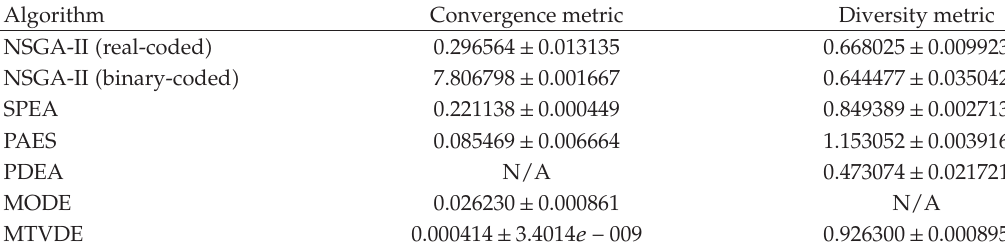
Table 5: Testing result’s statistics of the problem